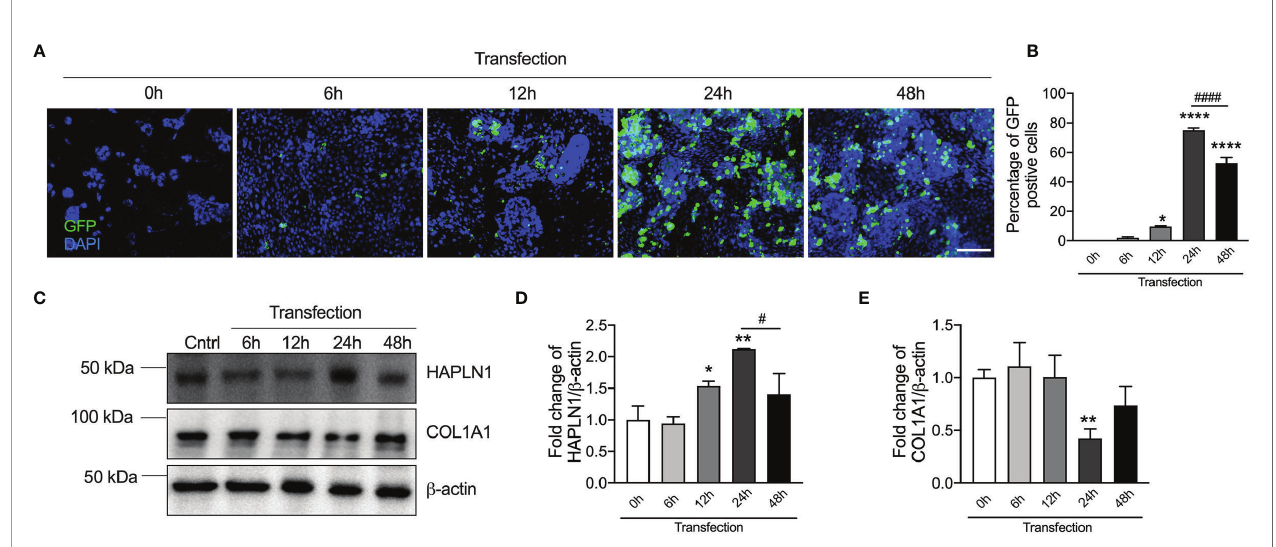
FIGURE 4 | HAPLN1 overexpression increases HAPLN1 but decreases COL1A1 proteins in human colorectal cancer (CRC) epithelial cells. HAPLN1 overexpression plasmids conjugated with GFP were transfected into human CRC epithelial (Caco-2) cells. (A) GFP-positive cells were assessed over a time course of transfection (0, 6, 12, 24, and 48 h) by immuno fl uorescence ( n = 4, scale bar = 100 m m), and (B) GFP-positive cells were normalized to total cells (per view). (C) HAPLN1 and COL1A1 proteins were assessed in cell lysates over a time course of HAPLN1 overexpression plasmid transfection (0, 6, 12, 24, and 48 h) by immunoblot. Fold changes of densitometry of HAPLN1 (D) and COL1A1 (E) were normalized to b -actin. n = 4. Results are mean ± SEM. * P < 0.05, ** P < 0.01, **** P < 0.0001 compared with cells 0 h after HAPLN1 overexpression plasmid transfection. # P < 0.05, #### P < 0.0001 compared with cells 48 h after HAPLN1 overexpression plasmid